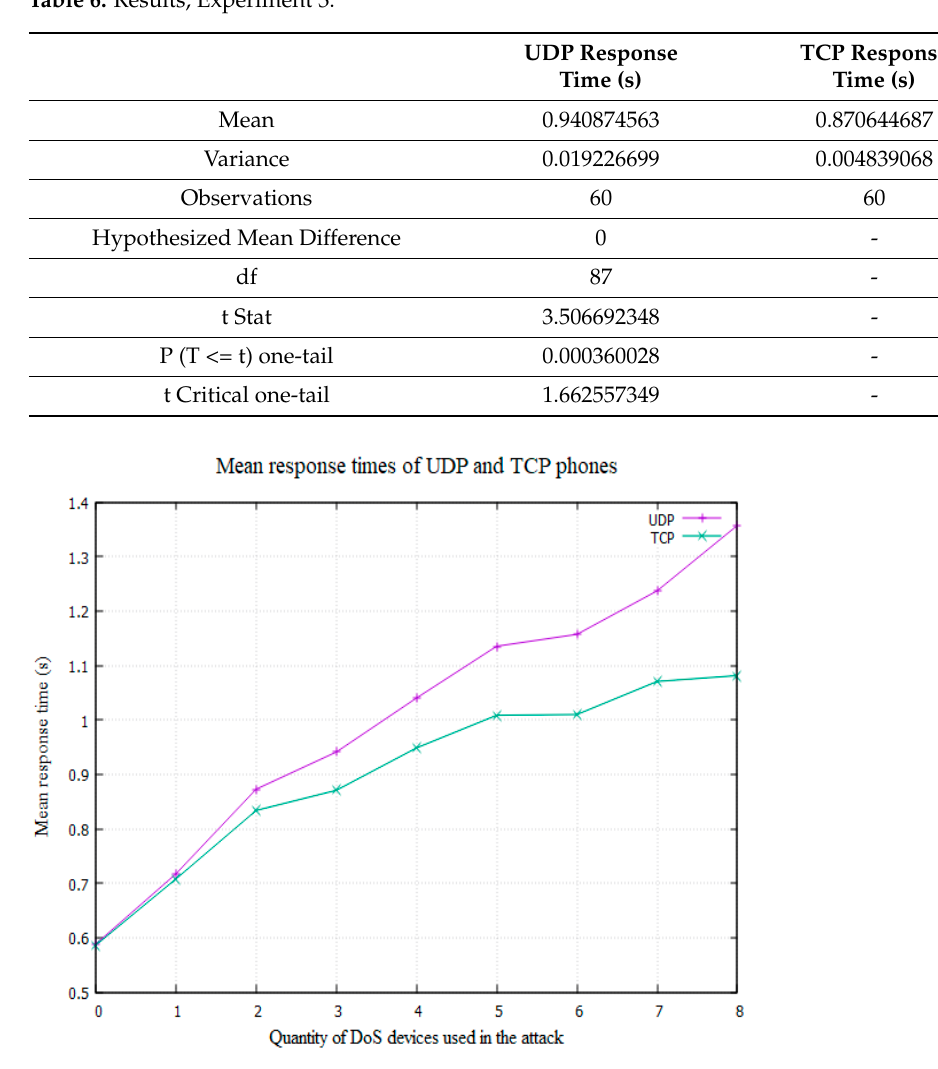
Figure 9. Graph displaying the mean response times of the UDP and TCP phones. Tables 7 and 8 display the outcome when the independent t -Test was carried out on the response times when a network was experiencing a DDoS attack from four and five devices,